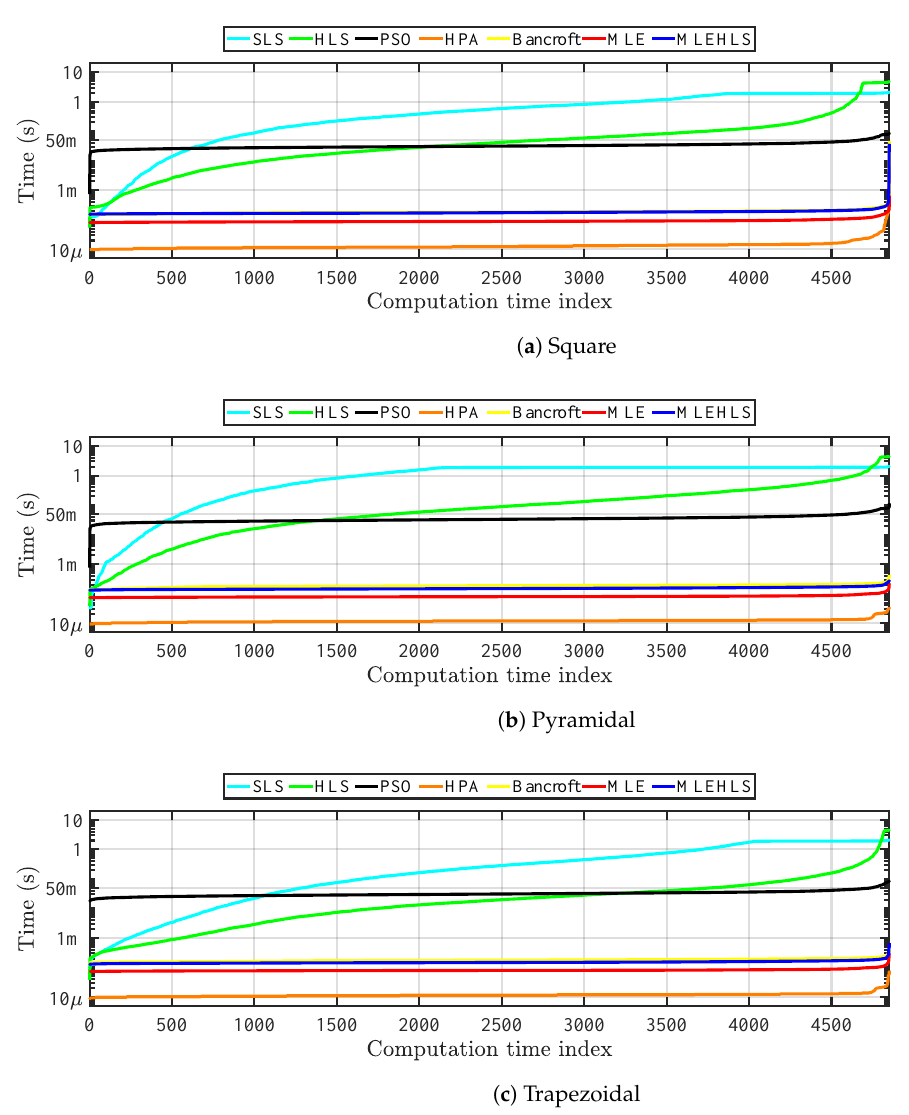
Figure 7. Computational time spent for each position analysed in theoretical conditions by each